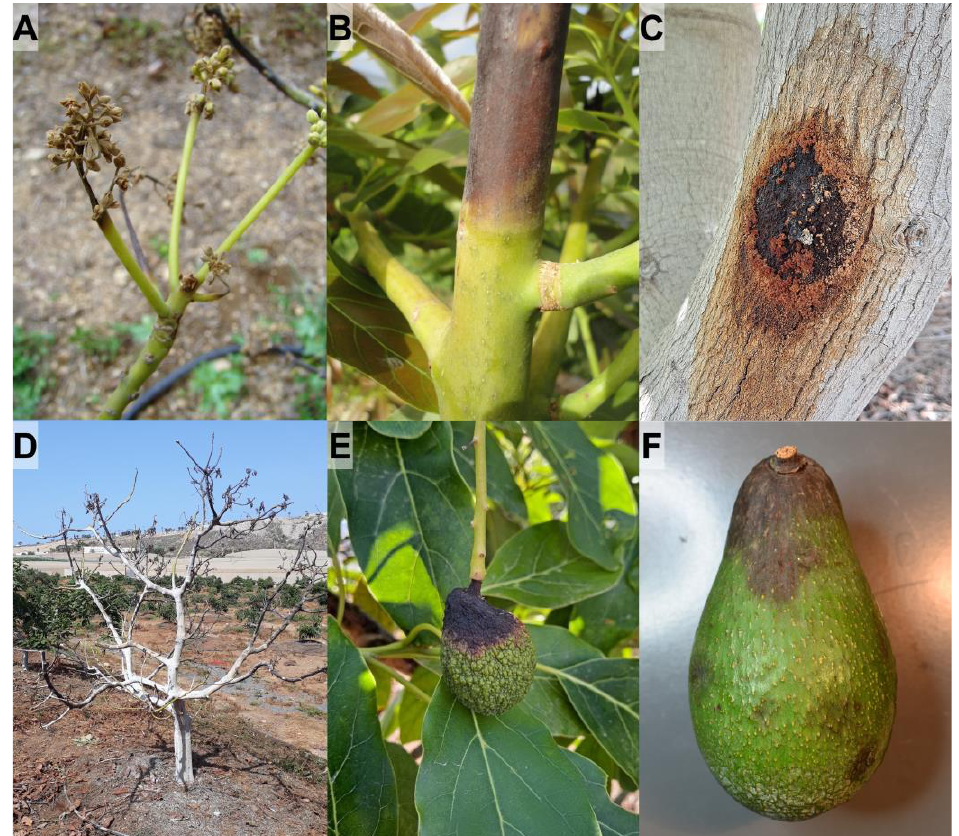
Figure 1. Symptoms usually observed in the aerial part of the avocado plants. ( A ), panicle blight; ( B ), branch dieback; ( C ), trunk canker; ( D ), collapse of entire young plant; ( E ), rots in developing fruits; ( F ), postharvest stem-end rot of fruit.